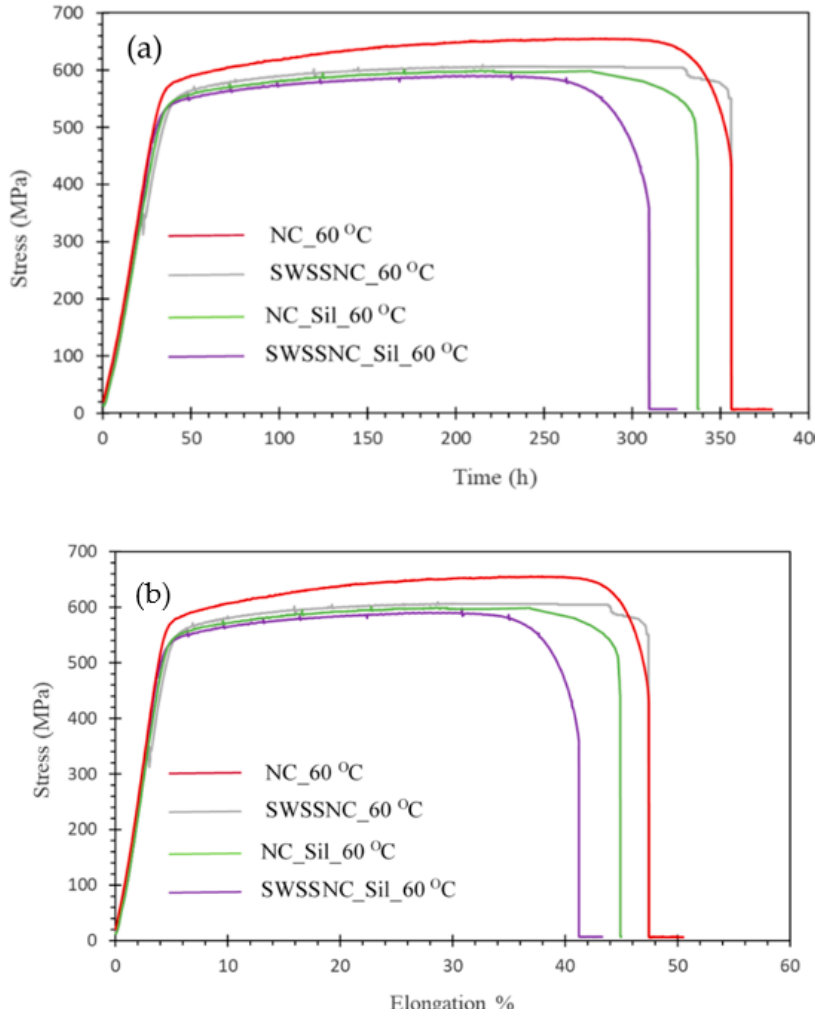
Figure 6. ( a ) Stress vs. time, and ( b ) stress vs. elongation plots of AISI 316 stainless steel alloy at strain rate of 3.7 × 10 − 7 s − 1 in the simulated solutions of NC and SWSSNC without and with silicate at 60 ◦ C. Table 2. The time to failure ( t f ), elongation to failure ( ε f ) and ultimate tensile strength ( UTS ) of 316 stainless steel samples in the simulated solutions of normal concrete (NC), seawater sea sand concrete (SWSSNC), NC with silica (NC_Sil) and SWSSC with silica (SWSSNC_Sil) at 60 ◦ C. Elongation to Failure Simulated Solution Time to Failure ( t f , h) ( ε f ,